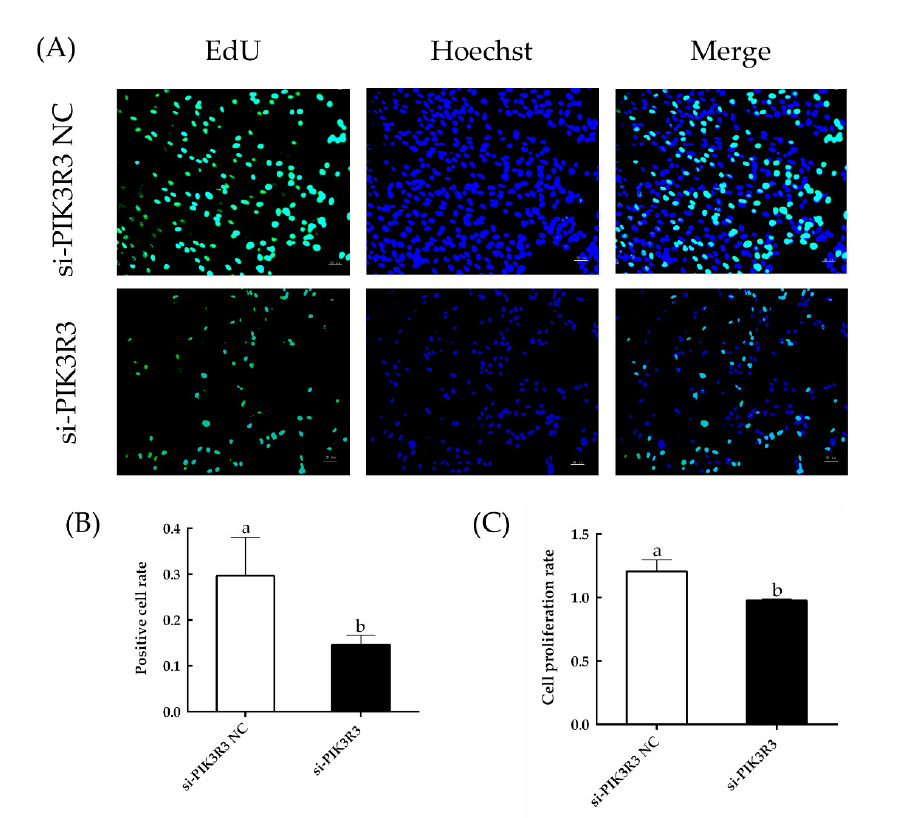
Figure 1. Effect of the siRNA-mediated knockdown of PIK3R3 expression. HFSCs were transfected with si-PIK3R3 or a negative control (NC) construct. The different small letters (a, b) in the same graph indicate that the difference between groups is statistically significant ( p < 0.05). ( A ) After 24 h of transfection, the expression of PIK3R3 gene was detected by RT-qPCR. ( B , C ) Relative expression of proteins to GAPDH in HFSCs.